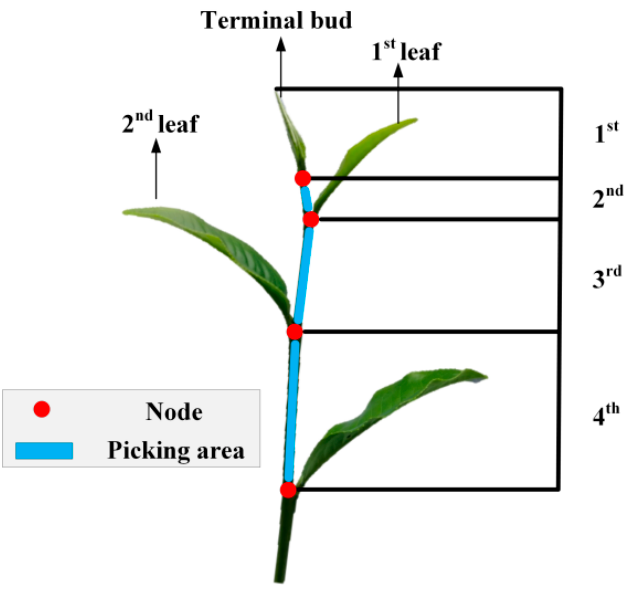
Figure 1. Tea section and picking areas.